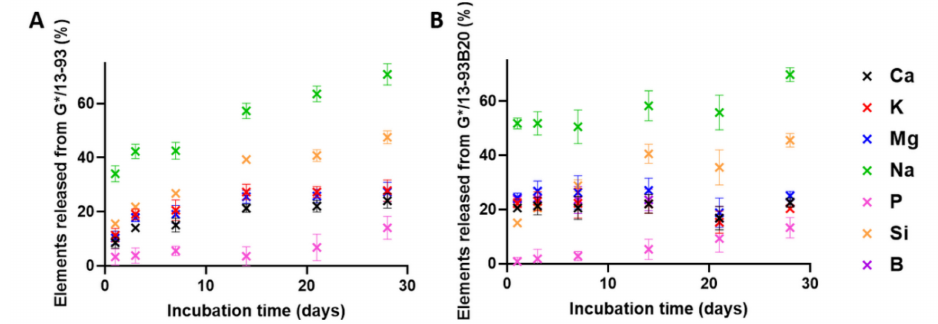
Figure 4. Release of ions from the ( A ) G*/13-93 and ( B ) G*/13-93B20 hybrids, immersed in TRIS as a function of time.